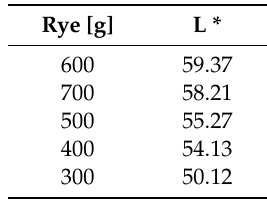
Table 2. Brightness (L *) of rye grains after roasting.